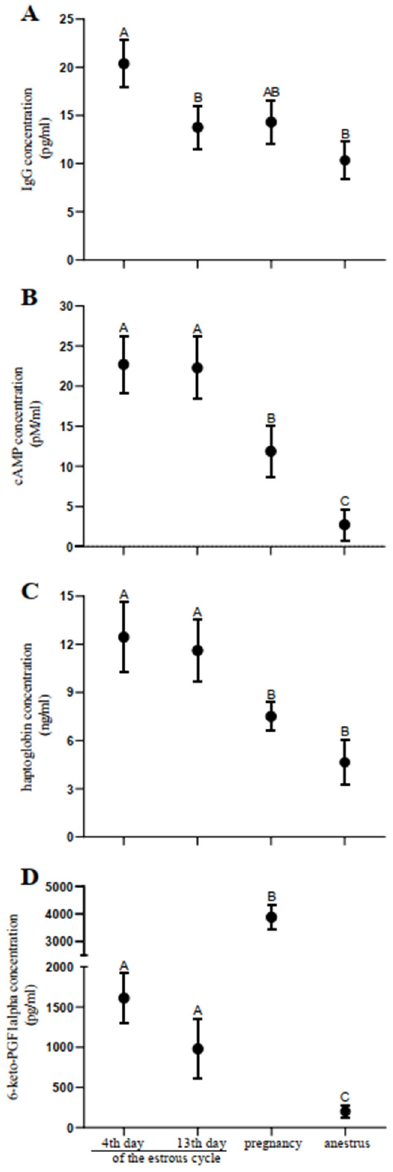
Figure 2. Plasma concentration of IgG ( A ), haptoglobin ( B ), cAMP ( C ), and 6-keto-PGF1 α ( D ) in the blood samples collected on 4th and 13th day of the estrous cycle, and during pregnancy and anestrus. Plasma concentrations were estimated using ELISA kits, according to the manufacturer’s instructions. Statistical differences were analyzed with one-way ANOVA, followed by the Kruskal–Wallis test, using GraphPad PRISM (Version 8.3.0). The lowest statistical significance indicated by different letters (A–C) was p < 0.05.